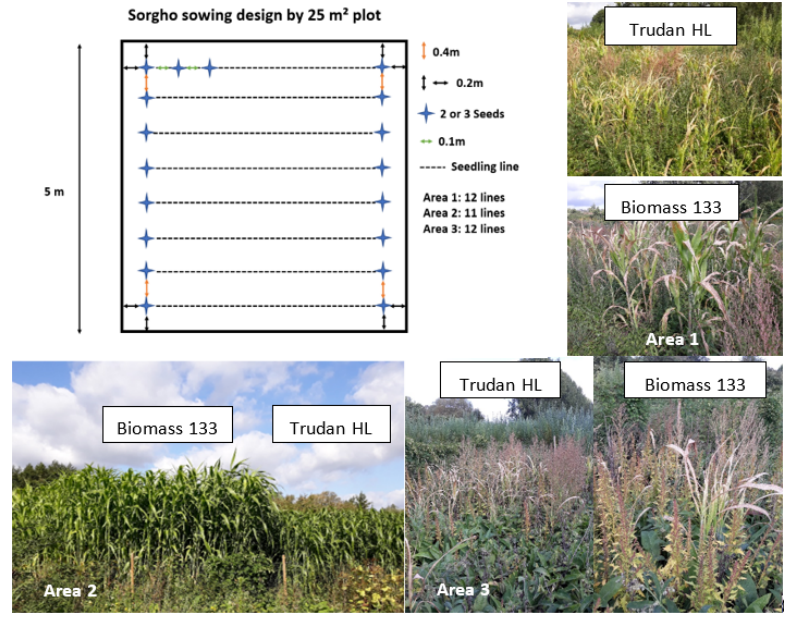
Figure 1. Sorghum sowing design and pictures of the two cultivars on the three areas 99 days after the sowing.